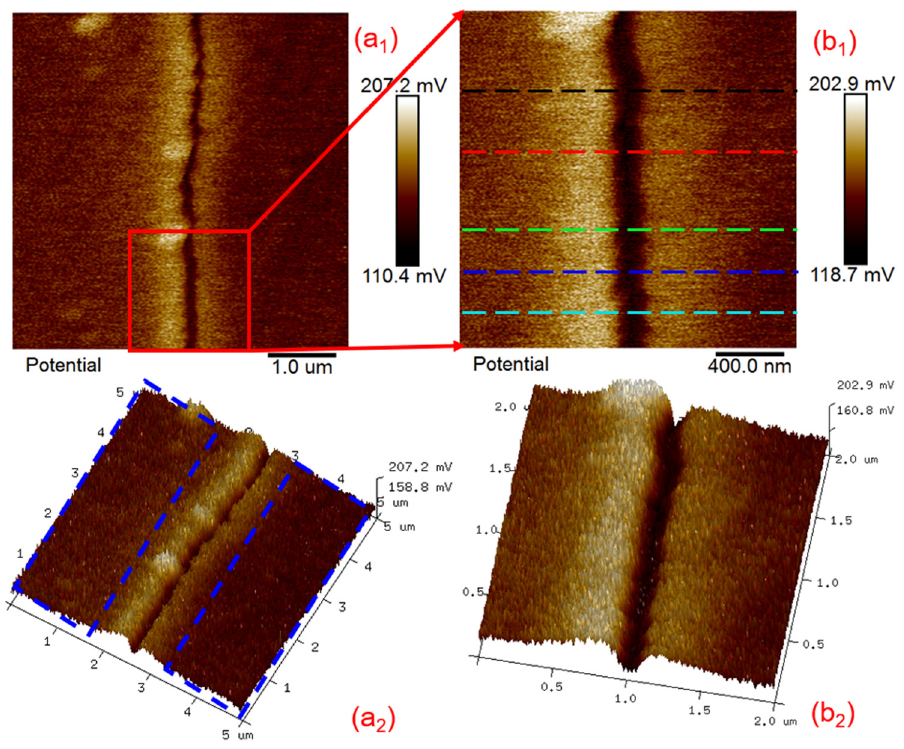
Figure 9. 2D images ( a 1 , b 1 ) and 3D ( a 2 , b 2 ) images of the surface potential about and around the new microcrack.